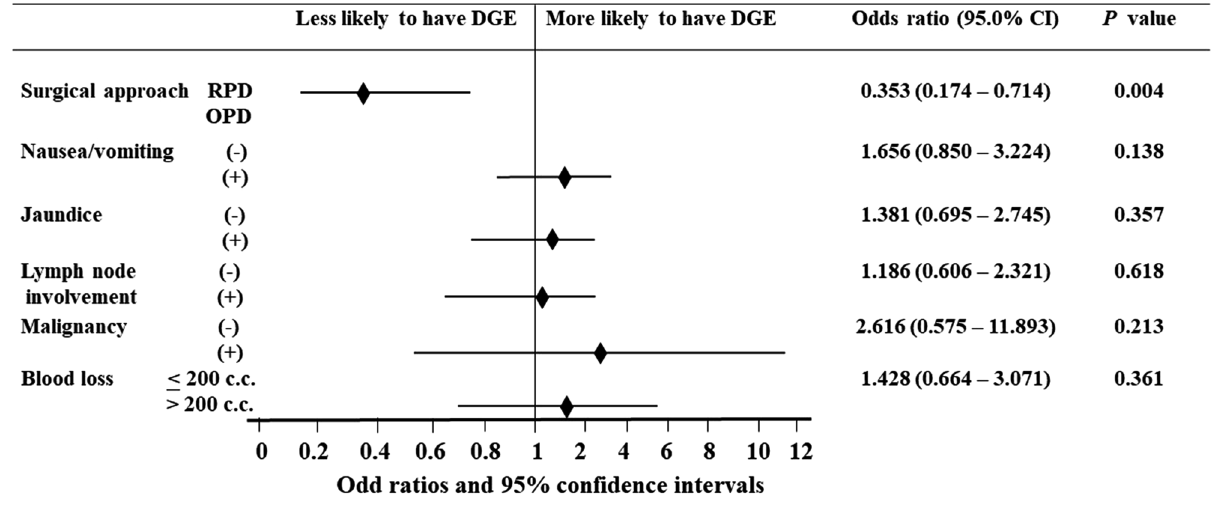
Figure 3. Forest plot, multivariate analysis by binary logistic regression for independent factors associated with delayed gastric emptying (DGE). CI: confidence interval, RPD: robotic pancreaticoduodenectomy, OPD: open